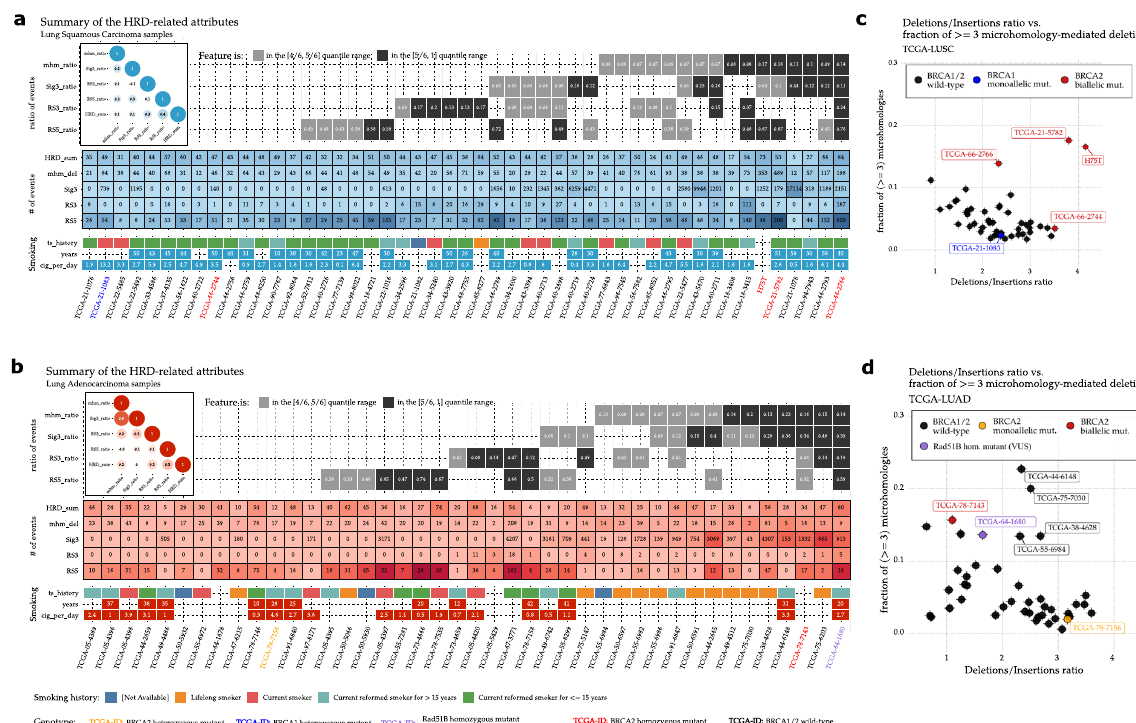
Fig. 1 Summary of the HRD-related predictors in the LUAD and LUSC whole-genome dataset. Summary of the HRD-related molecular features extracted from the LUSC ( a ) and LUAD ( b ) whole-genome cohorts. The considered features are as follows: HRD_sum - the sum of the three allele-speci fi c CNV-derived genomic scars scores (HRD-LOH + LST + ntAI), RS3_ratio : Rearrangement signature 3 ratio, i.e., the number of structural variants originating from Rearrangement Signature 3 (RS3), divided by the total number of structural variants in the sample, RS5_ratio: Rearrangement Signature 5 ratio, i.e., the number of structural variants originating from rearrangement signatures 5 (RS5), divided by the total number of structural variants in the sample, mhm_ratio: the ratio of microhomology-mediated deletions, i.e. the number of deletions, that begin with at least three consecutive nucleotides that it shares with the sequence that follows the deletion (mhm_del), divided by the total number of deletions, Sig3_ratio: Substitution signature 3 ratio, i.e., the number of somatic point mutations that can be contributed to the activity of the molecular process captured by Substitution Signature 3 (Sig3), divided by the total number of single nucleotide somatic mutations. The top sections of the two panels contain dark and light gray tiles, which represent the positions of the samples within the distributions of each of the above-described features. A dark gray tile means, that the corresponding ratio (vertical axis) of the sample (horizontal axis) is among the highest within the cohort; it lies between the 5th and 6th sextiles, i.e., above the 83rd percentile. A light gray tile indicates that the corresponding feature ratio is between the 4th and 5th sextiles, i.e., between the 66th and 83rd percentiles. Below the ratio panels, the absolute number of markers is displayed. The bottom section of the panels shows the available tobacco history of the samples. Empty tiles either indicate that at the time of data collection the donor was registered as a non-smoker, or that the information was not available. On the top left sections of the two panels, two correlograms show the Pearson correlation coef fi cients between all the ratio pairs. Apart from the correlation coef fi cient between the Signature 3 and microhomology-mediated deletion ratios within the LUAD cohort, all other coef fi cients were mediocre or negligibly small. Fraction of microhomology-mediated deletions with larger or equal to 3 bp in length, versus the deletions/insertions ratio in the LUSC ( c ) and LUAD ( d )